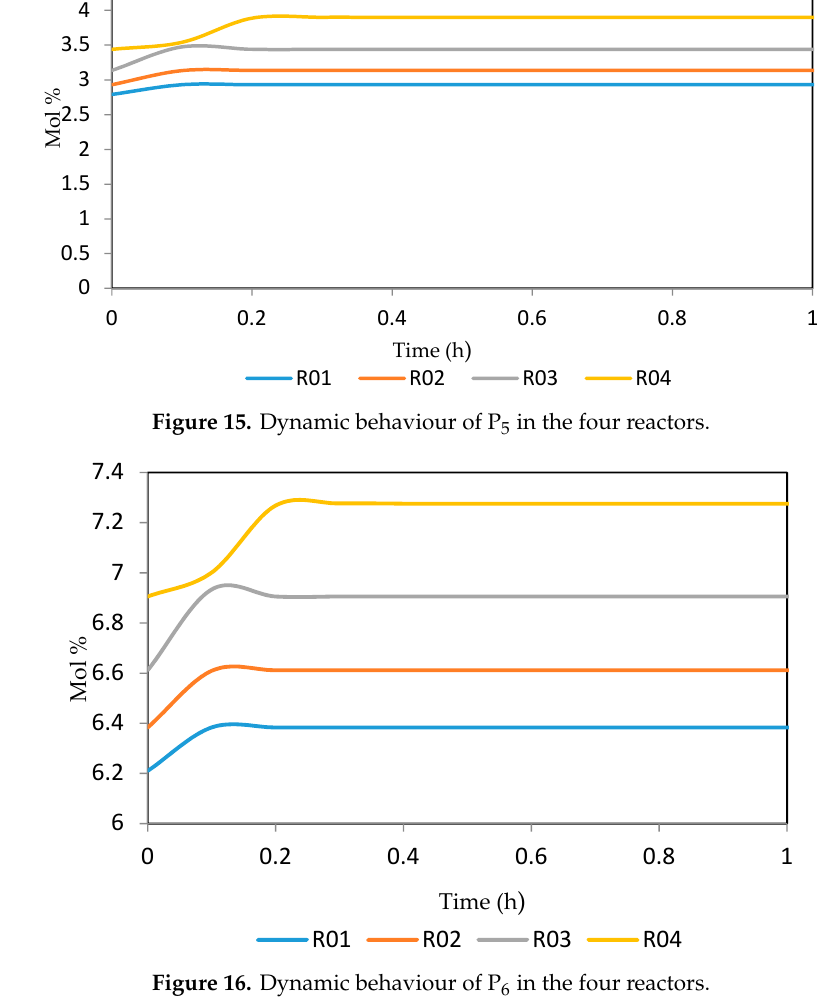
Figure 17. Dynamic behaviour of P 7 in the four reactors.